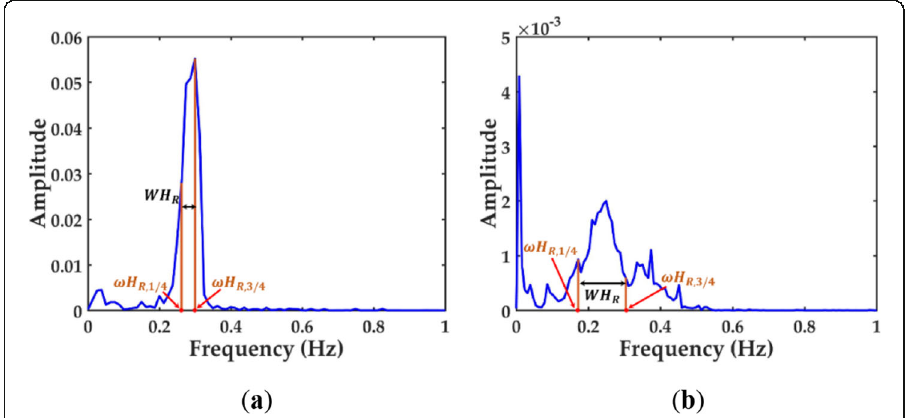
Fig. 9 Comparison of ω H R , 1/4 , ω H R , 3/4 , and WH R between human and dog targets. a Human target. b Dog target